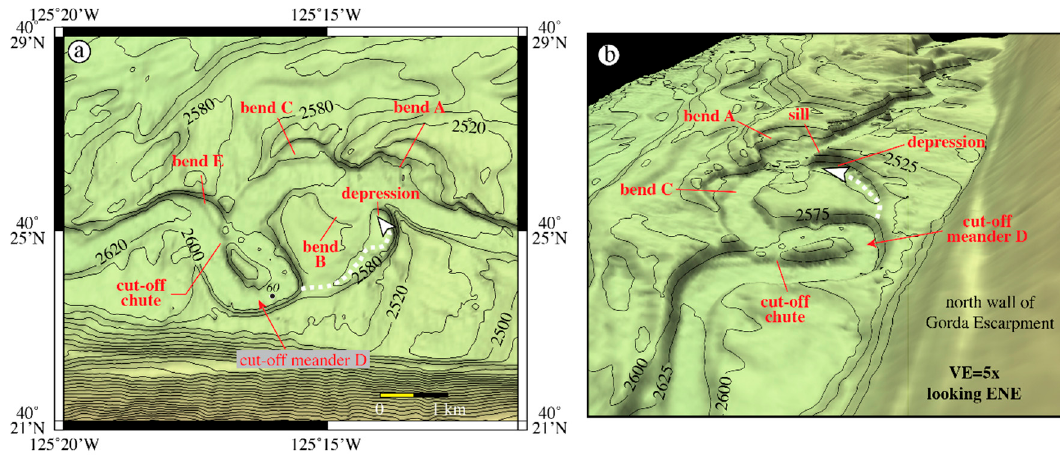
Figure 11. ( a ) Map view of middle of upper sinuous reach (USinR) that shows the cut-off chute that created cut-off meander D and the depression and channel on the southern bank of bend A perched 18 m above the adjacent floor of the USinR. White dashed arrow marks the path of the abandoned channel that leads to the depression. Black circles mark distances in km in italics from the junction of Mendocino and Mattole Canyons. Isobaths of Gorda Escarpment intentionally left unlabeled; ( b ) Perspective view of the same area and features.